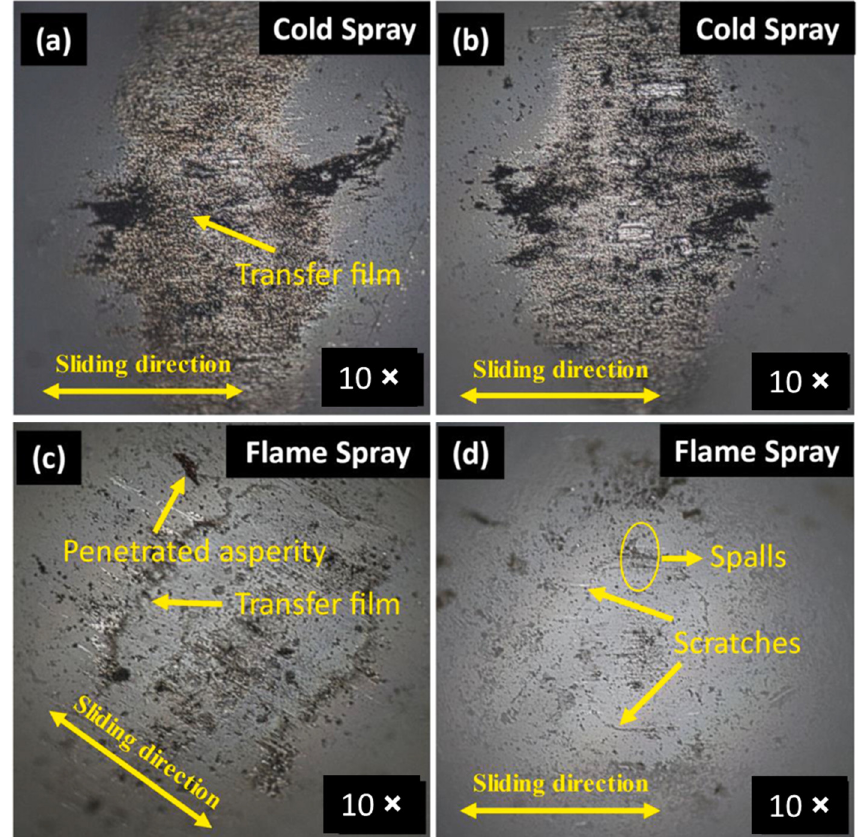
Figure 13. Optical microscopy images of alumina counter balls after sliding at 5 N load for ( a ) un- polished, ( b ) polished cold-sprayed HEA coatings, ( c ) unpolished and ( d ) polished flame-sprayed AlCoCrFeMo HEA coatings [95].